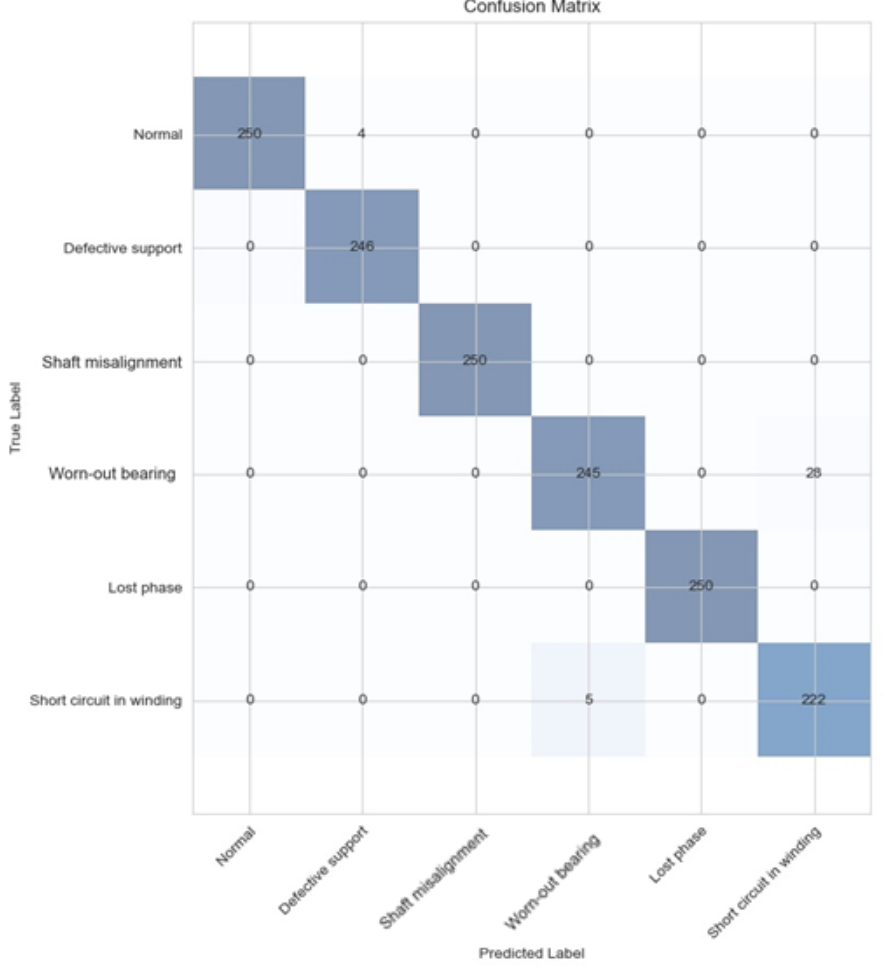
Figure 13. Test results of best performing model, summarized in confusion matrix.